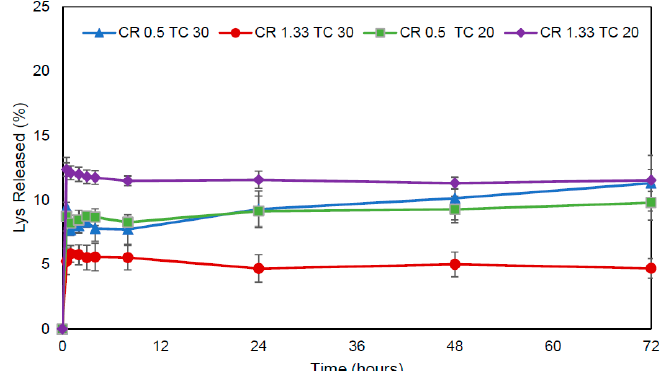
Figure 6. Lys released from pNPs loaded EE/alginate to 30% w / w in various CR and TC. Data represent mean values ± SD ( n = 3) p < 0.05 post-hoc Tukey’s.